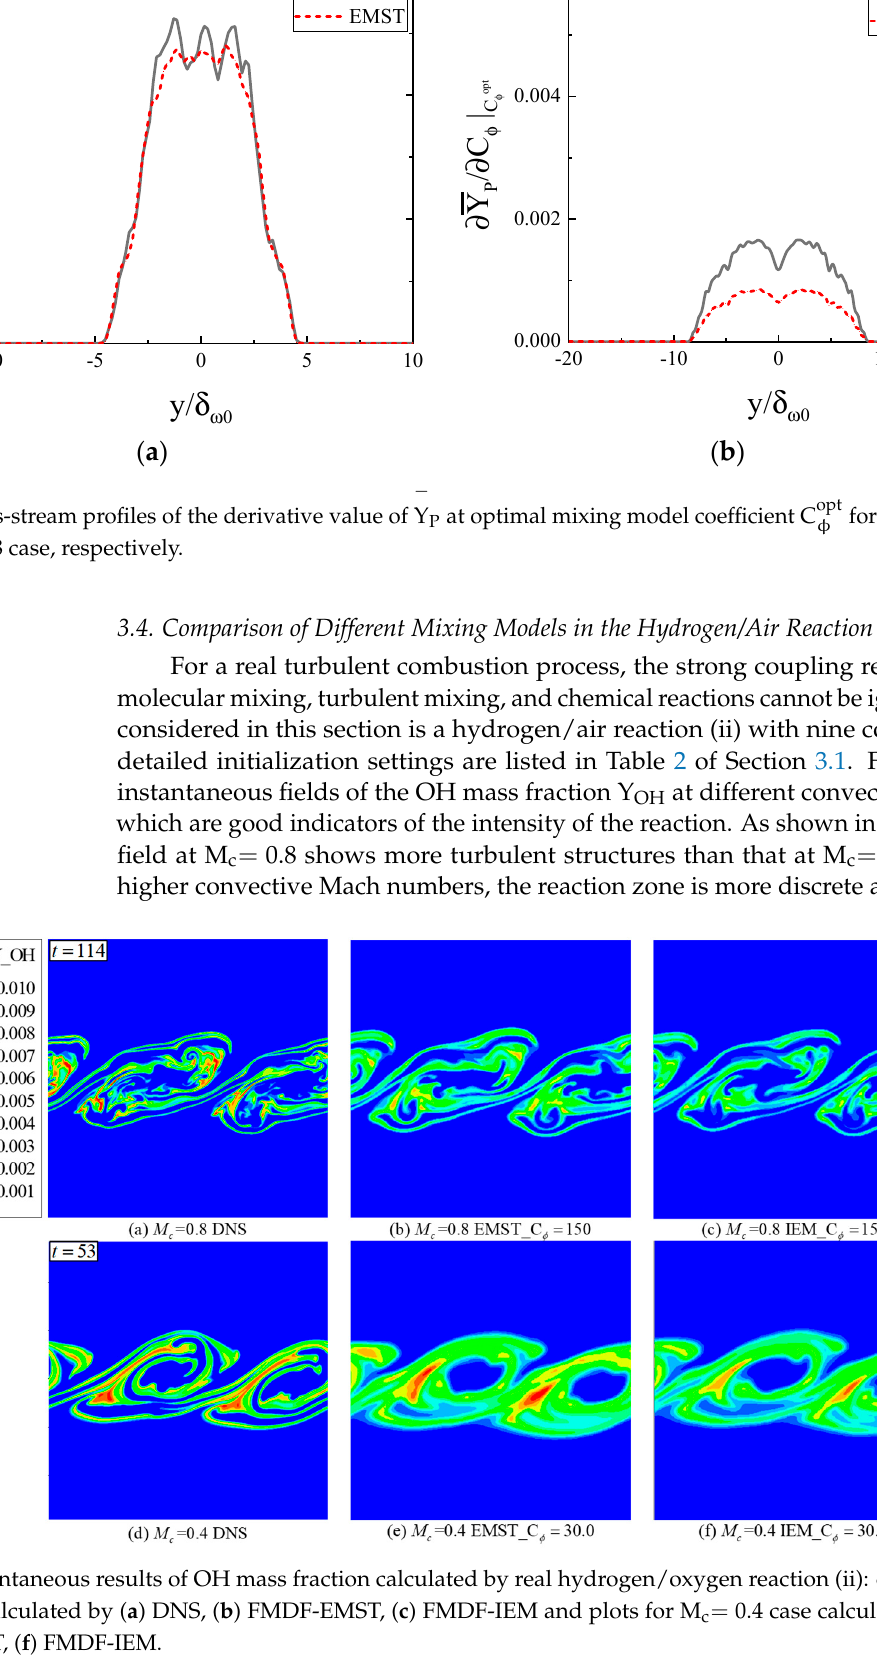
( e ) FMDF-EMST, (f) FMDF-IEM. ( e ) FMDF-EMST, ( f )